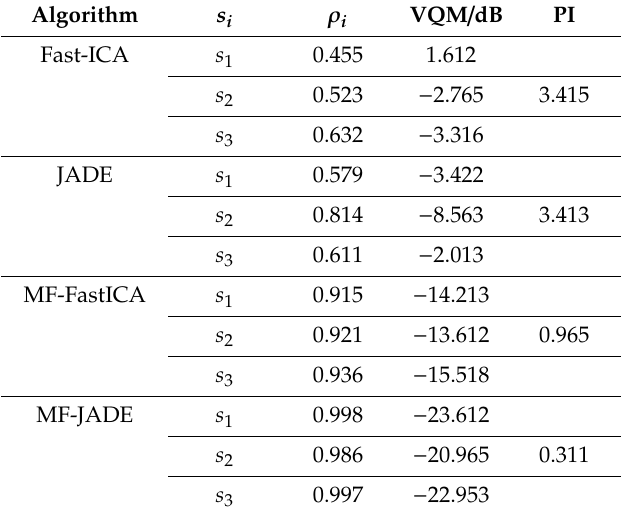
Table 1. Evaluation indices comparison for blind source